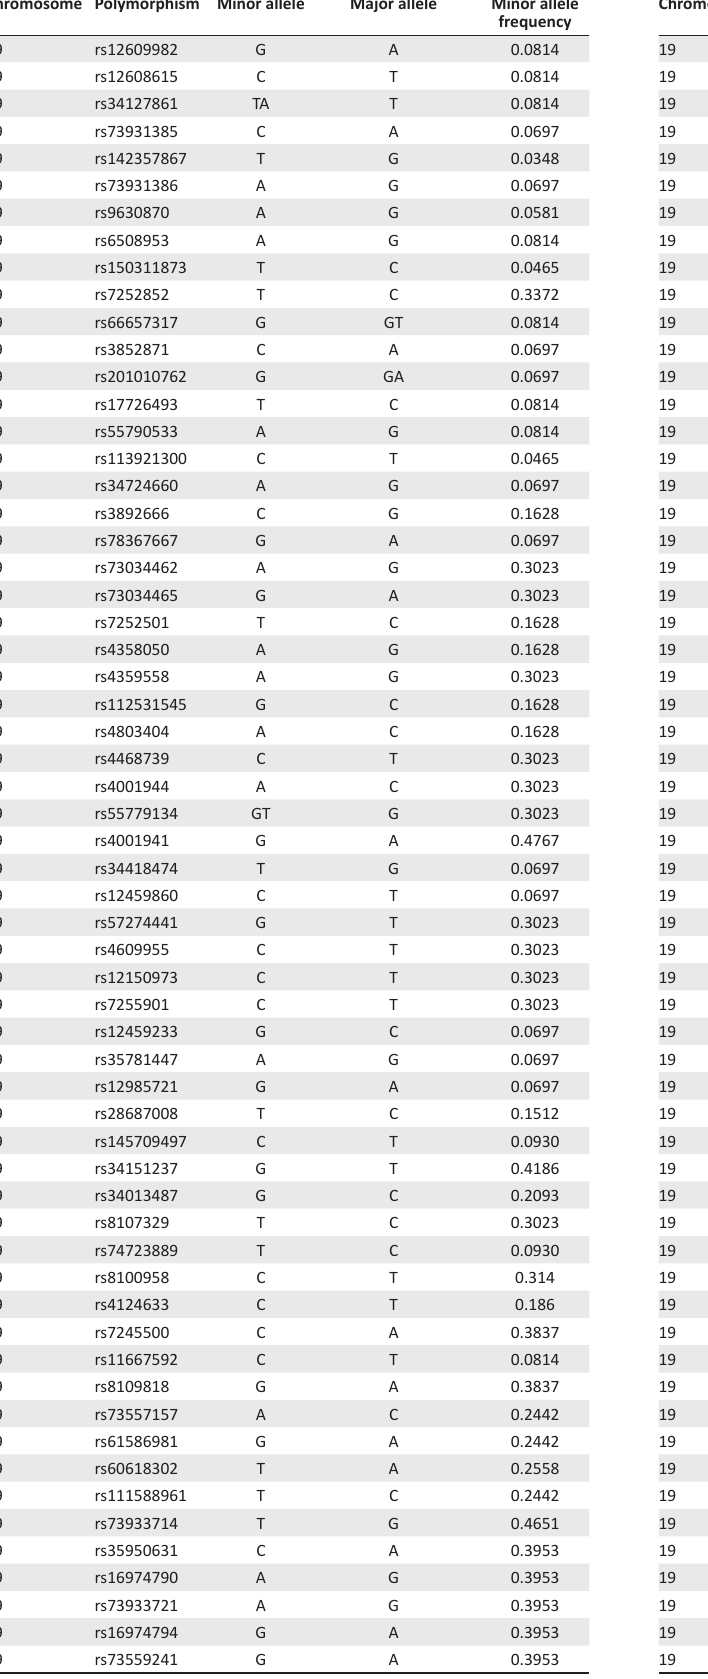
Table 1-A1 continues on the next page →Table 1-A1 continues in the next column